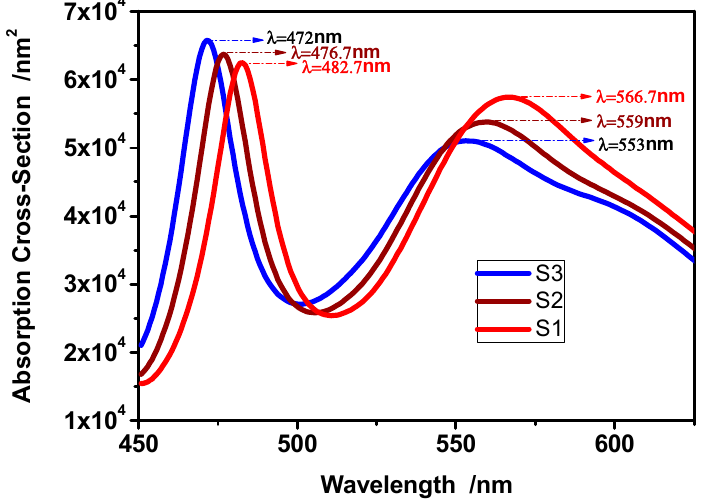
Figure 3. The simulated absorption intensity of the core–shell samples S1, S2, and S3, and their corresponding resonance wavelengths.